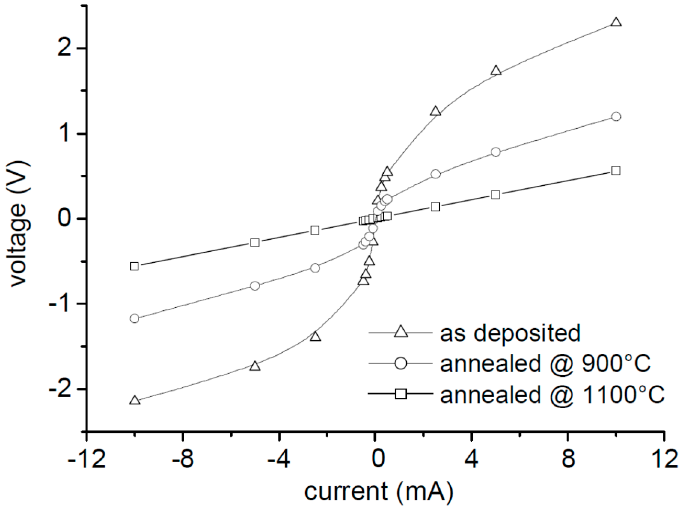
Figure 2. I–V characteristics of samples from SiC-wafer after rapid thermal annealing (RTA) at different temperatures.